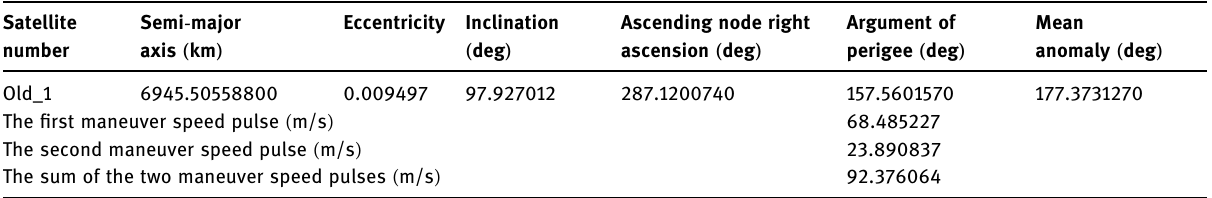
Table 3: Orbital parameters after dispatching Old_1 satellite